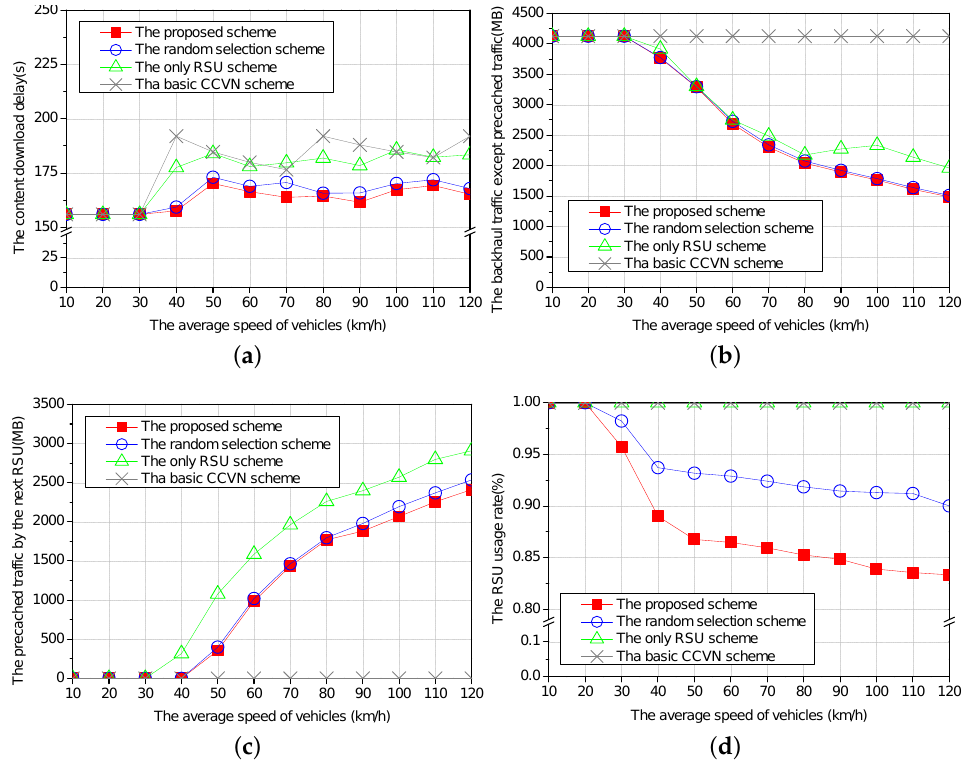
Figure 5. Simulation results for different speeds of the requester vehicle : ( a ) the content download delay, ( b ) the backhaul traffic except precached traffic, ( c ) the precached traffic by next RSU, and ( d ) the RSU usage